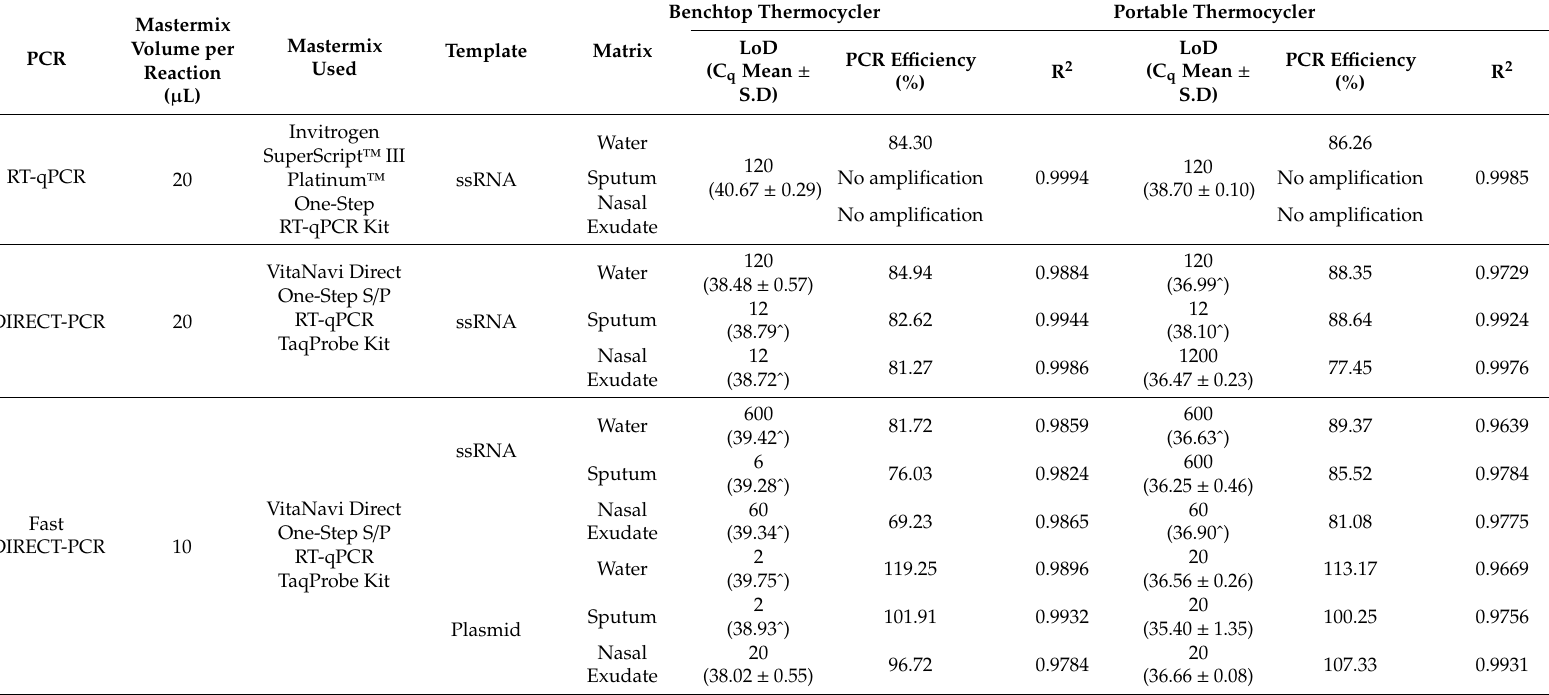
Table 1. Limit of detection (LoD) in copies per PCR reaction volume and PCR e ffi ciency of DIRECT-PCR for SARS-CoV-2 on benchtop and portable